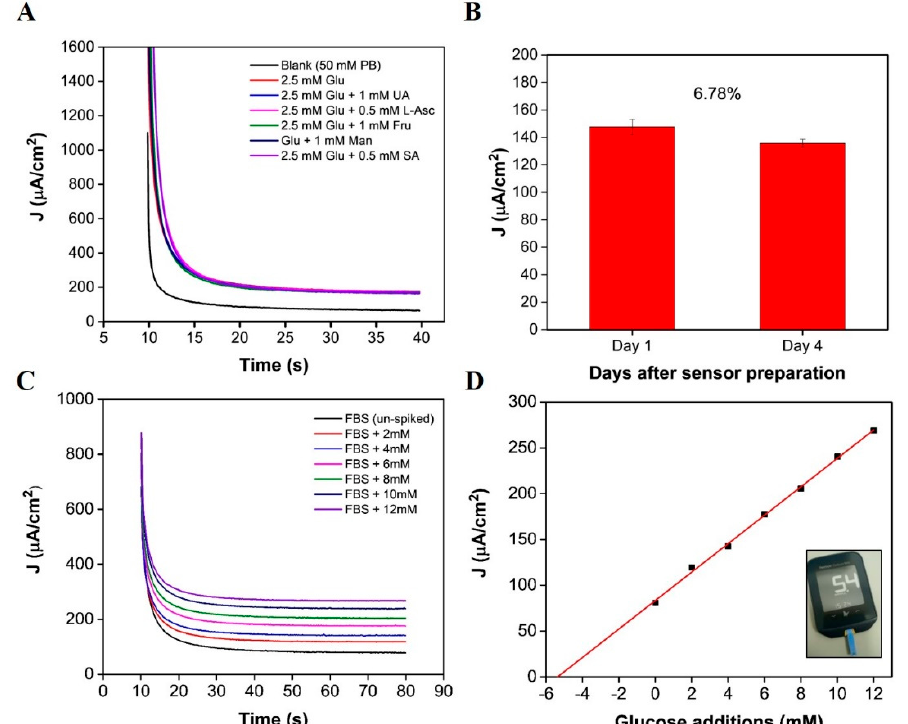
Figure 5. ( A ) Chronoamperometric response of the on-chip biosensor to a blank solution (50 mM PB, pH 7.4), to 2.5 mM glucose and to separate aliquots of 2.5 mM glucose + other potential interfering species (L-ascorbic acid (L-A) fructose (Fru), mannose (Man), uric acid (UA) and salicylic acid (SA); ( B ) bar chart depicting the 2.5 mM concentration measured after 1 day of storage and a 2.5 mM concentration measured 4 days after storage (error bars represent std. dev between 50 data points obtained from 20–40 s current sampling time of measurement); ( C ) chronoamperometric response of the sensor in 100% fetal bovine serum spiked with known concentrations of glucose; ( D ) corresponding standard addition for subfigure ( C ) (inset image shows 1 of 10 measurements obtained in FBS). Table 1. A comparison of the on-chip ultramicroelectrode glucose sensor, presented here with other reagent-free miniaturized enzymatic glucose biosensors, constructed towards various biomedical sensing applications. Electrode Material *